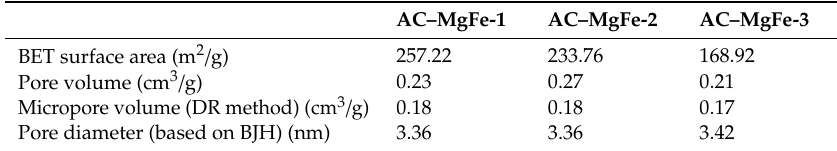
Table 1. Surface area, pore volume, and pore size of AC–MgFe